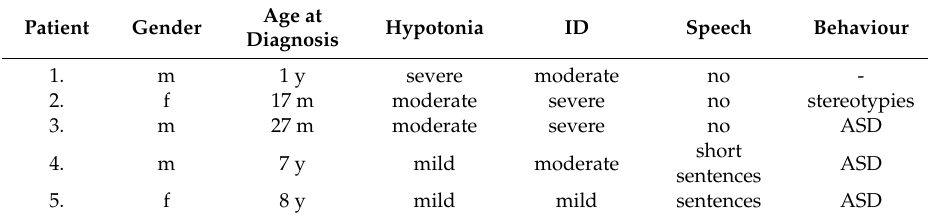
Table 3. Summary of the patients’ main clinical